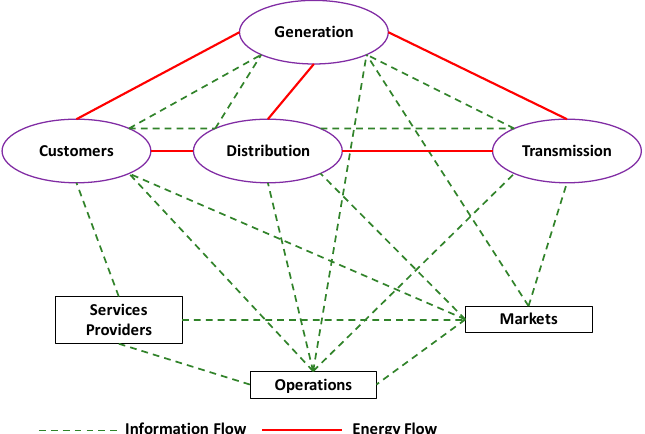
Figure 13. Conceptual model of a smart grid [130].